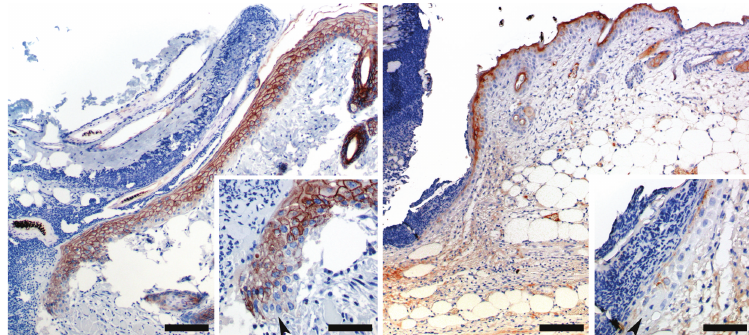
Figure 1: Cadherin staining 48h postincisional wounding in vivo . Left Panel: E-cadherin immunoreactivity at wound margin 48h after introduction of an incisional wound. Bar = 150 μ m. Inset: Higher magnification of the advancing edge of epithelium. Note that E- cadherin immunoreactivity is present in all but a few cells at the very tip of the migrating epithelium. Bar = 50 μ m. Right Panel: Desmoglein immunoreactivity at wound margin 48 h after introduction of an incisional wound. Bar = 150 μ m. Inset: Higher magnification of the advancing edge of epithelium. Note that desmoglein immunoreactivity is largely absent from the tip of the migrating epithelium. Bar = 50 μ